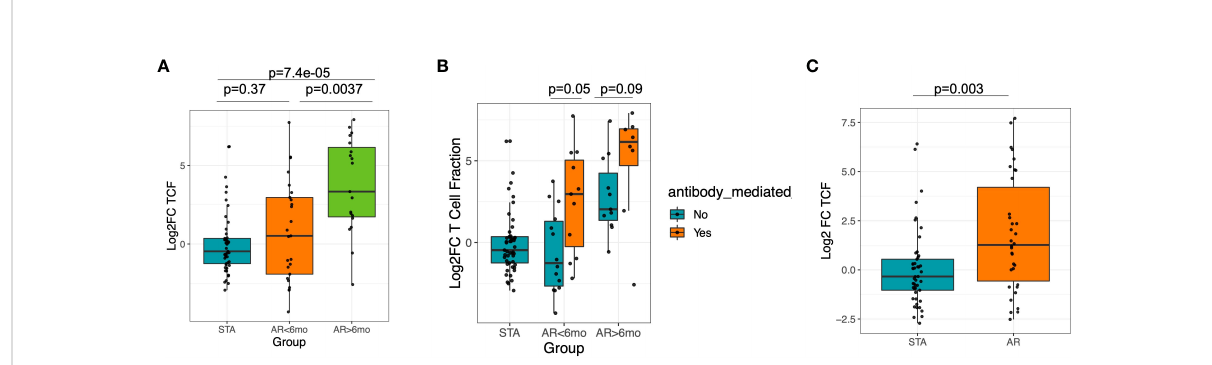
FIGURE 3 Signi fi cant increase in T-cell fraction at late rejection and in ABMR. (A) Increase of T-cell fraction is signi fi cant in late rejection cases >6 mo post-transplantation. (B) There is increase in T-cell fraction in ABMR compared to non-ABMR samples. (C) There was an increased peripheral T- cell fraction among AR subjects compared to STA among AR samples collected at 6 mo